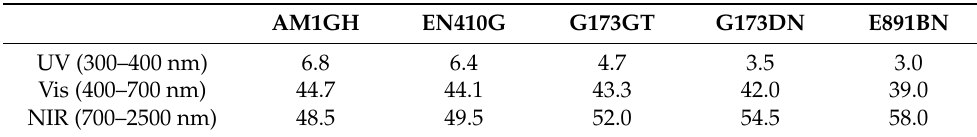
Table 1. Energy content (%) of solar spectra in the UV-Vis-NIR